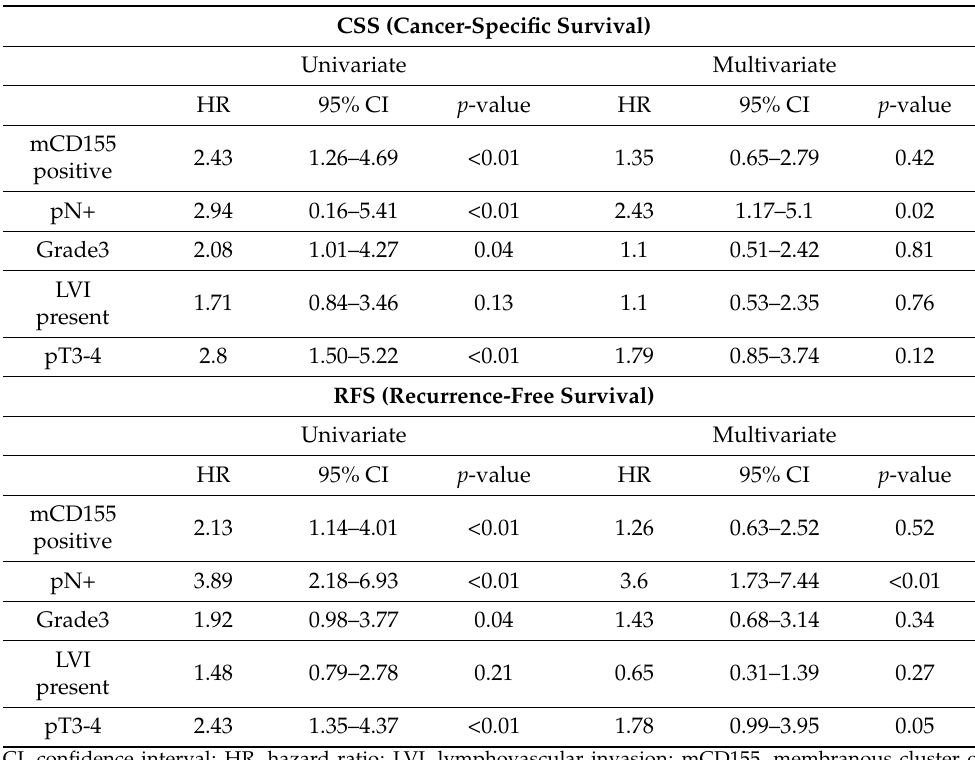
Table 2. Univariate and multivariate Cox proportional hazards analyses to predict cancer-specific survival and recurrence free survival in patients with bladder cancer treated with radical cystectomy. CSS (Cancer-Specific